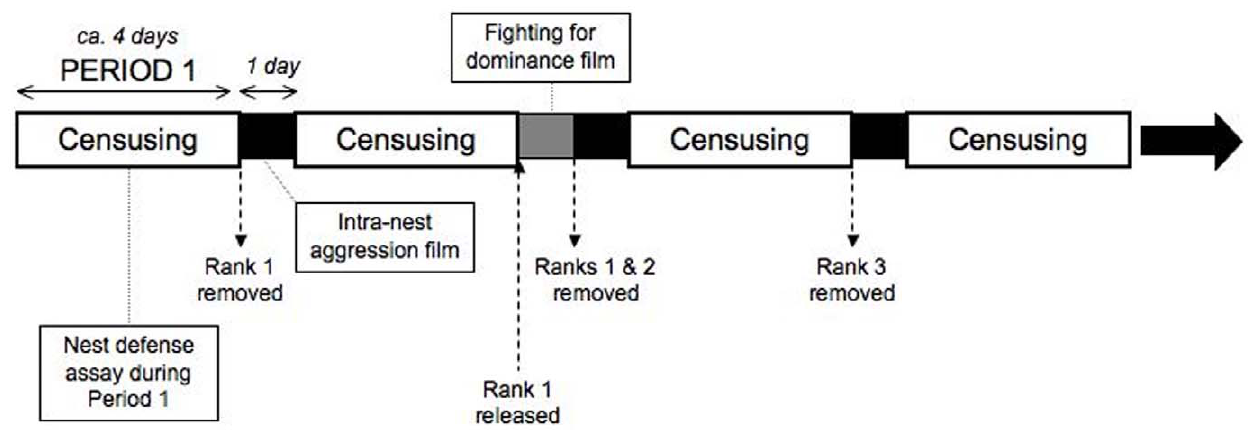
Figure 1. Sequence of experiments. Black/grey sections represent one day of no censusing. Observations continued until the rank of each wasp on the nest was known (pausing for bad weather).